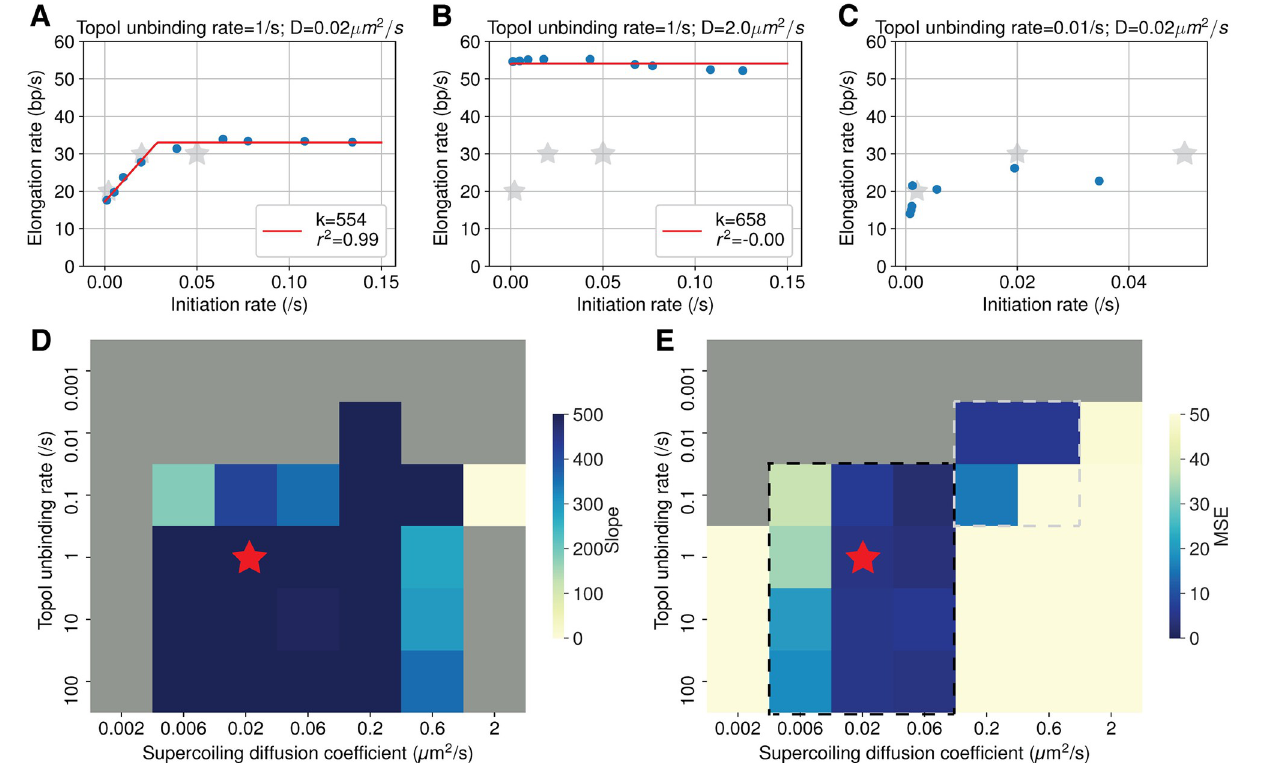
Fig 3. Cooperation holds under the condition of fast Topo I unbinding and moderate supercoiling diffusion. (A to C) Examples of the elongation rate– initiation rate curves (blue dots) and the corresponding piecewise linear fitting (red lines) for three different combinations of the Topo I unbinding rate and supercoil diffusion rate. Fitting is only performed for scenarios where the maximum empirical initiation rate is greater than 0.05 s − 1 (i.e., C is not fitted). The fitted slope ( k ) values and fitting goodness ( r 2 ) were displayed in the legend. Grey stars correspond to the experimental data in Kim et al . [13]. (D) Heatmap of RNAP cooperativity, characterized by the slope of the elongation rate–initiation rate curve, under different supercoiling diffusion coefficients and Topo I unbinding rates. The grey region corresponds to the regime where the fitting goodness r 2 is below 0.85, or the fitting is not performed (maximum initiation rate < 0.05 s − 1 ). The red star indicates parameters used in the rest of the paper. (E) Heatmap of the mean squared error (MSE) between the model and the experimental data from Kim et al .